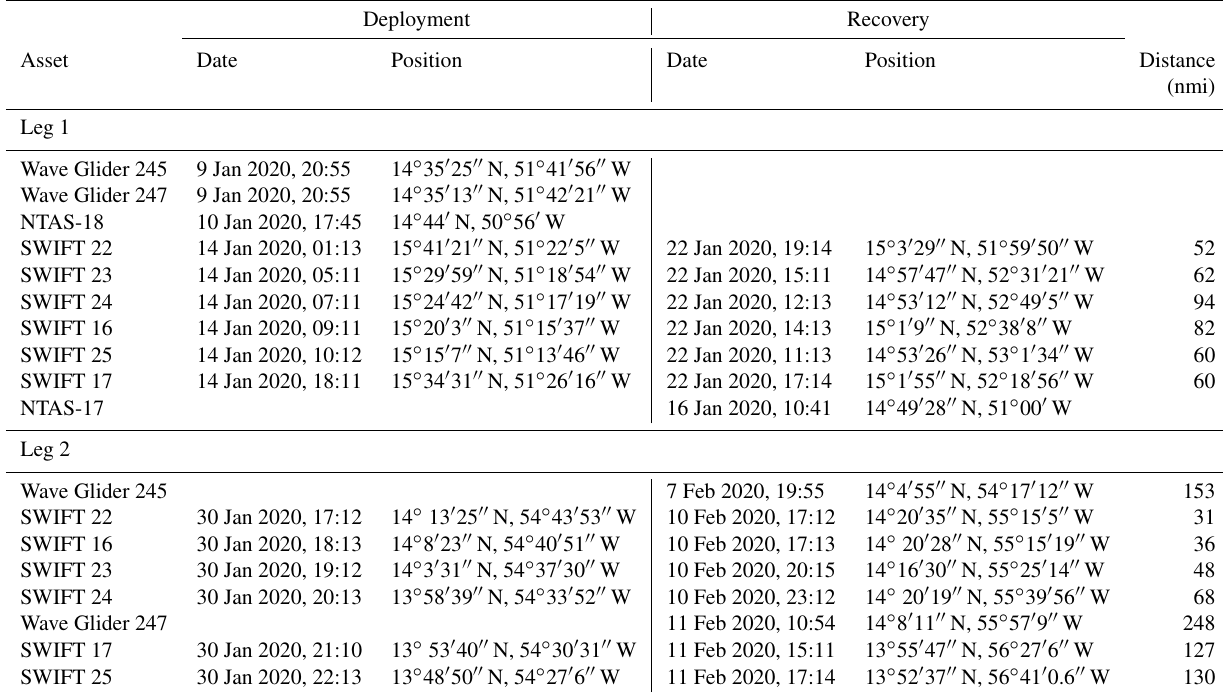
Table 2. Dates (UTC) and positions of deployment and recovery of NTAS moorings, two Wave Gliders, and six SWIFTs. Assets are listed in order of start and stop times of the data stream. Distance traveled is given for the SWIFTs and Wave Gliders.